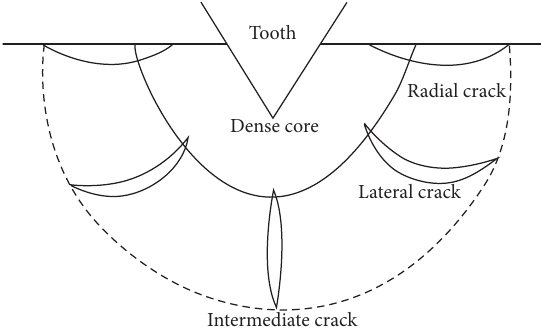
Figure 11: Graph for the tooth penetrating the